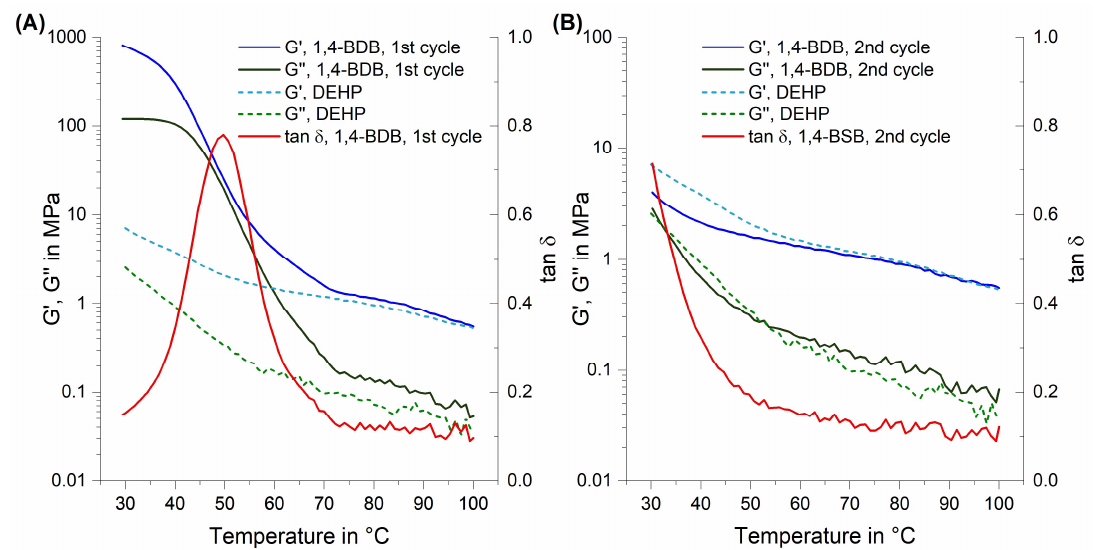
Figure 4. Log plot of torsional DMTA temperature sweep curves: G’ (blue) and G” (green) for 40 phr blends of PVC/1,4-BDB and PVC/DEHP, and tan δ (red) for PVC/1,4-BDB in temperature sweep mode. ( A ) The first heating cycle; and ( B ) the second heating cycle, started within 1 h of the first.